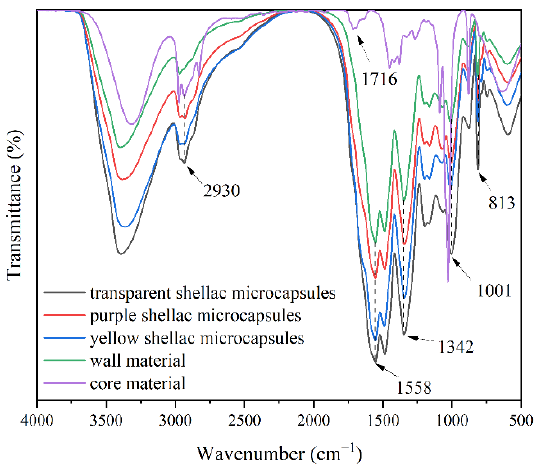
Figure 3. FTIR of the wall material, core material, purple shellac microcapsules, yellow shellac microcapsules, and transparent shellac microcapsules.